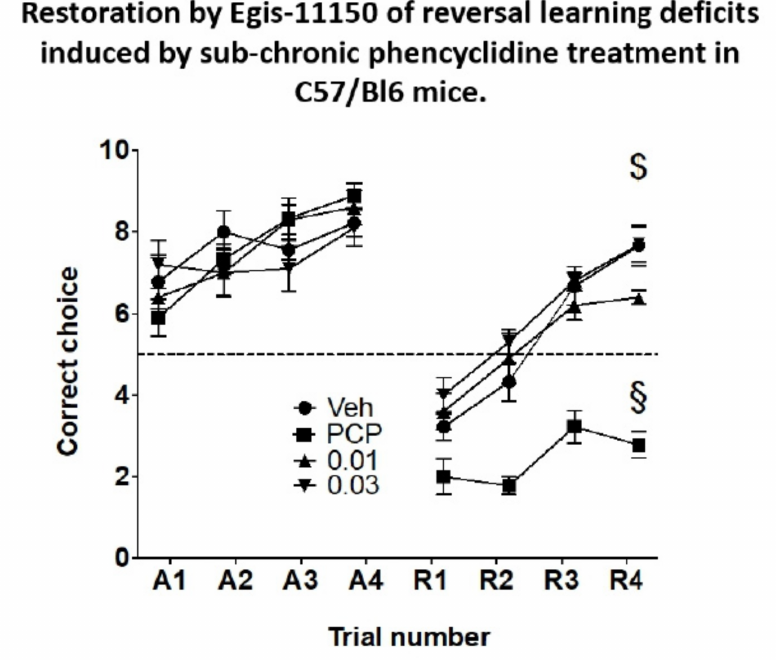
Figure 9. Impaired reversal learning by C57/Bl6 mice subjected to sub-chronic treatment with PCP is ameliorated by acute administration of Egis-11150 (0.03 and 0.1 mg/kg p.o.). Error scores of four acquisition sessions (left panel) and four reversal sessions (right panel) are shown. Data are mean ± SEM n = 10/group. Two-way ANOVA gave significant interaction drug treatment and trial number: F (9, 136) = 2.998, p = 0.0027. Dunnett’s post-hoc test: $ p < 0.001 for both 0.03 and 0.1 doses vs. the respective PCP treated group acutely receiving vehicle, § p < 0.001 when compared to the group receiving sub-chronic as well as acute treatment with vehicle. (A = acquisition trials, R = reversal